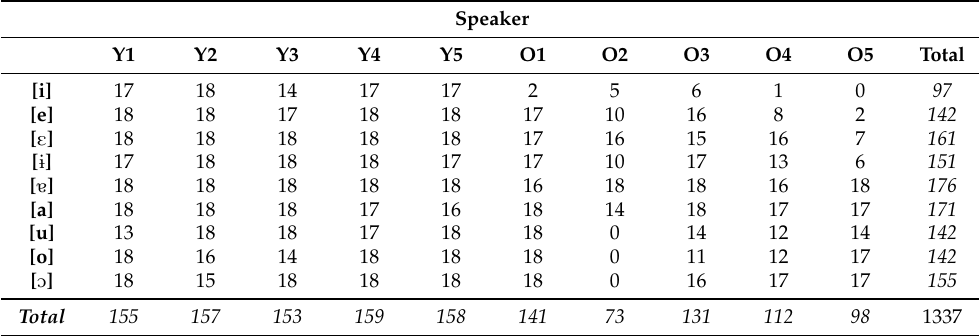
Table 3. Number of vowels analyzed per speaker and vowel type after removing some of the data due to poor image